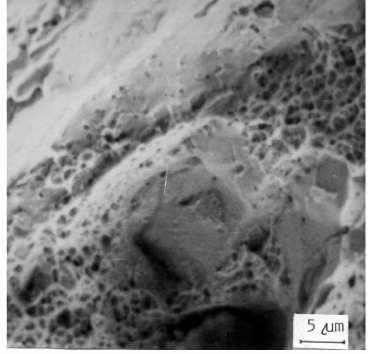
Figure 14. Morphology of E 508 B cladding